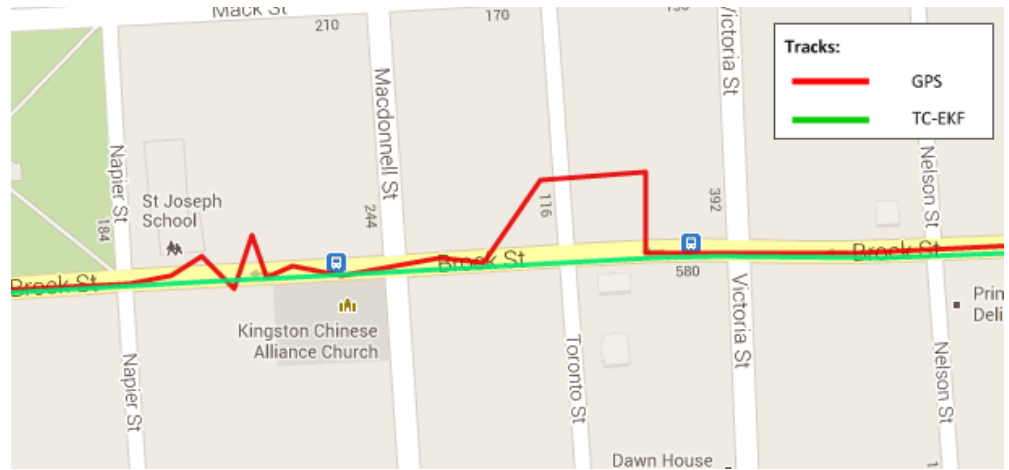
Figure 10. Noisy GPS during the Kingston downtown trajectory.